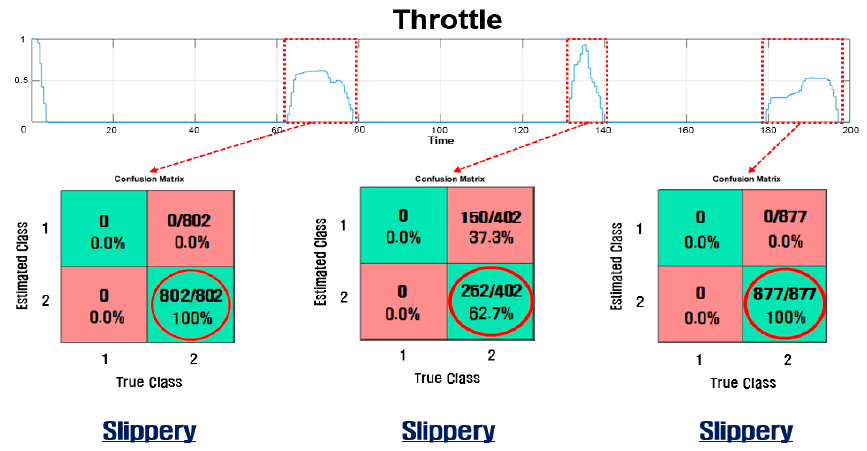
Figure 9. Classification of the road condition while the throttle is on. Table 3. Result of classification test depending on friction coefficient.